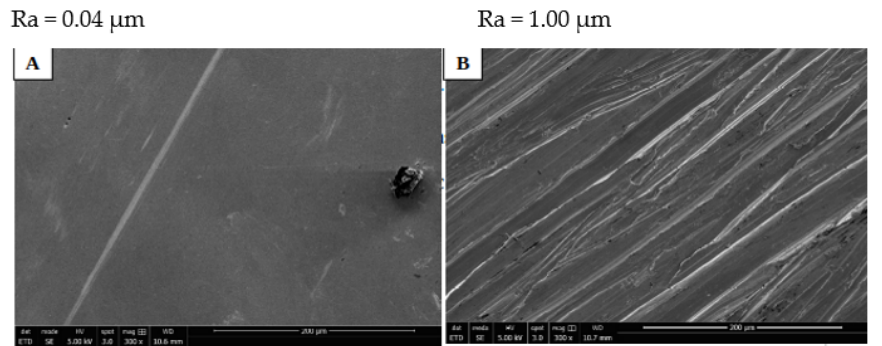
Figure 1. SEM images of: ( A ) mirror polished (S_TiNb) and ( B ) rough (R_TiCp) discs . Bars indicate the scale (similar magnification).